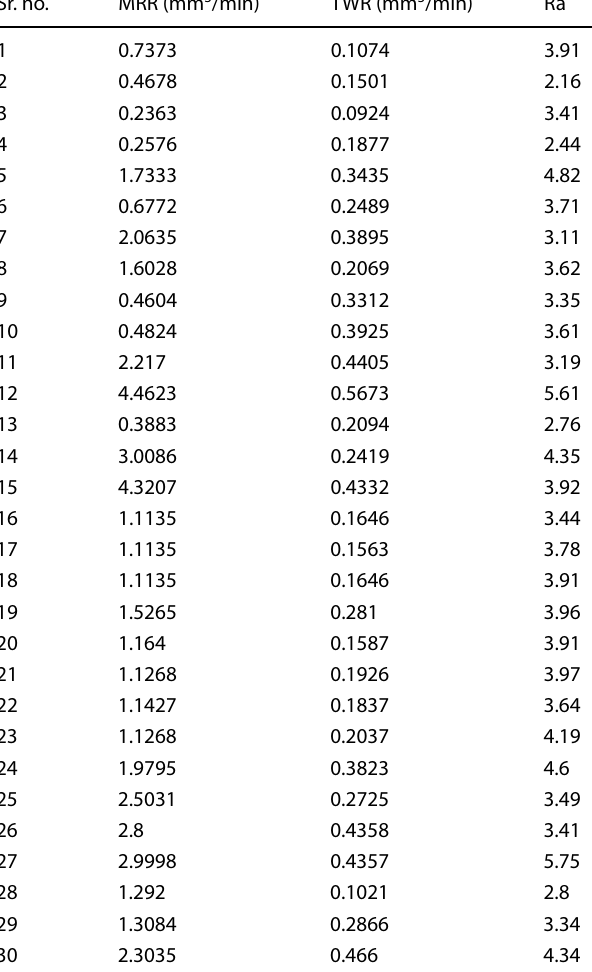
Table 5 Responses (average) MRR, TWR, and SR Sr.